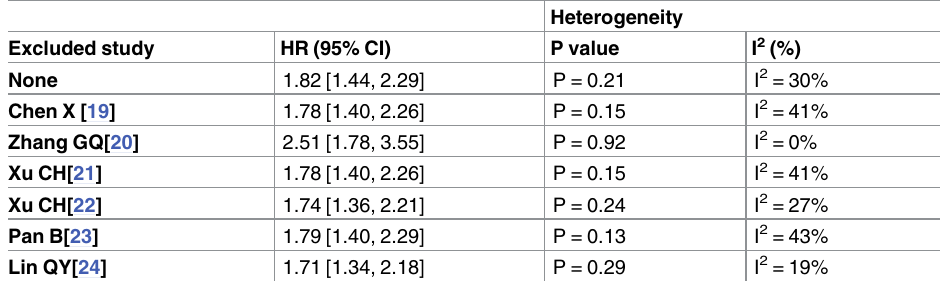
Table 4. Sensitivity analysis results on overall survival (OS).